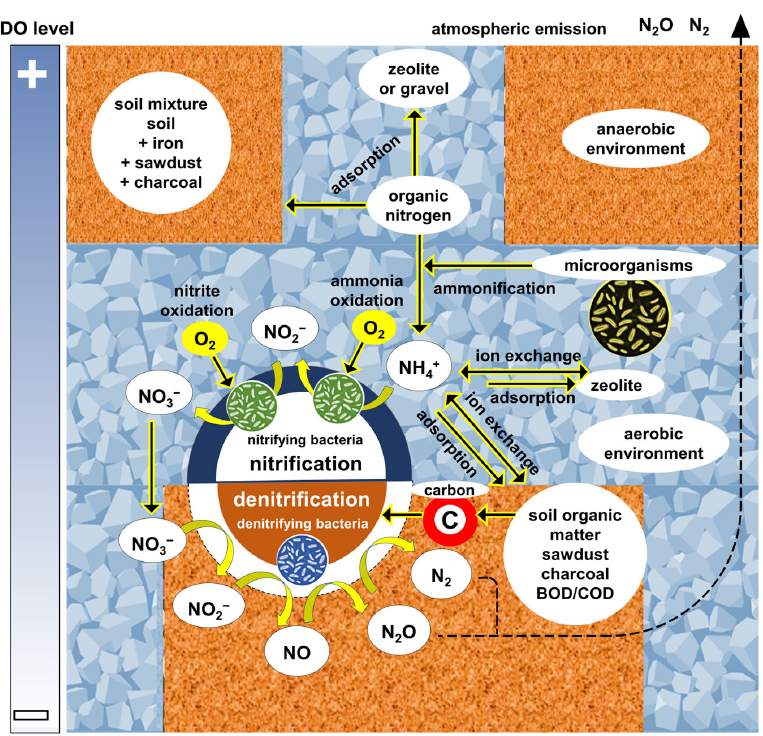
Figure 6. MSL layers design associated with the removal mechanisms of nitrogen.